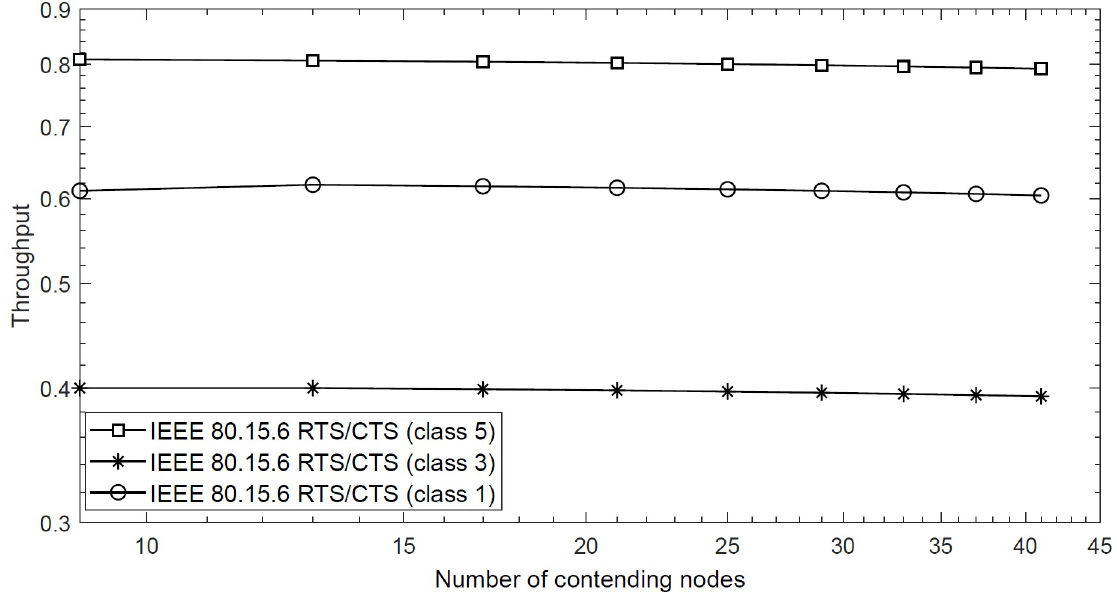
Figure 6. Saturation throughput of the RTS/CTS scheme for different classes with BER = 10 − 5 .